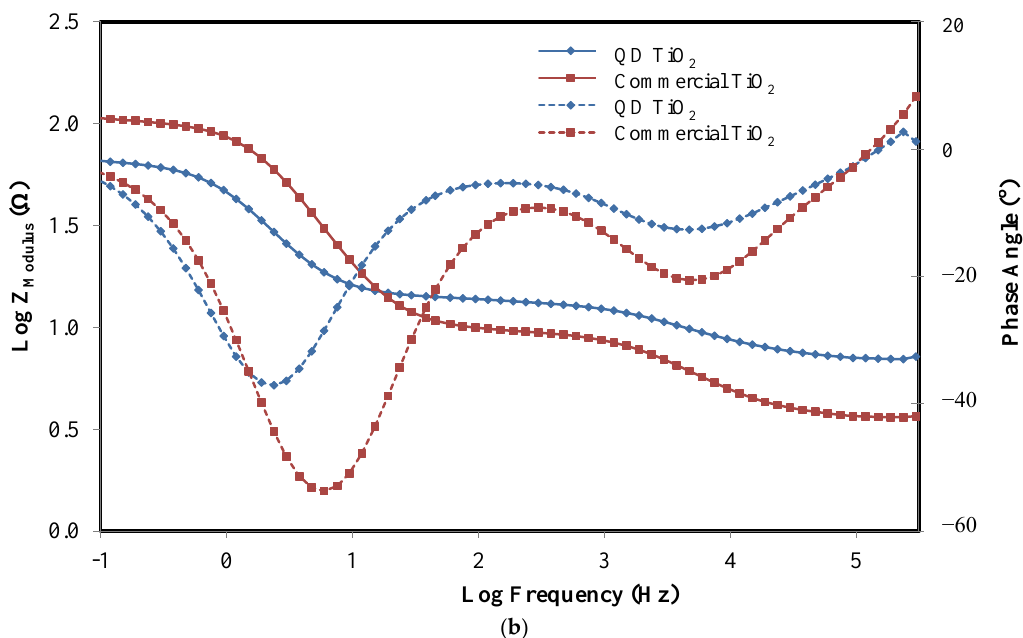
Figure 8. ( a ) Nyquist plot, and ( b ) Bode and phase plot of the QD TiO 2 and commercial TiO 2 nanoparticle-based DSCs. Table 2. Electrochemical properties of the QD TiO 2 and commercial TiO 2 nanoparticle-based DSCs. Sample